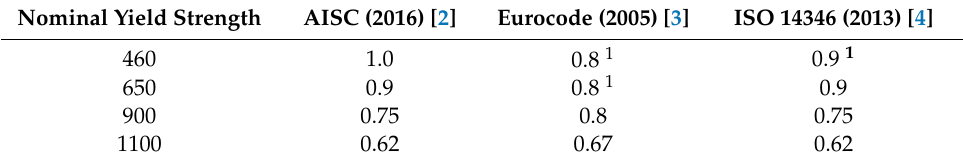
Table 13. Reduction factors for high-strength